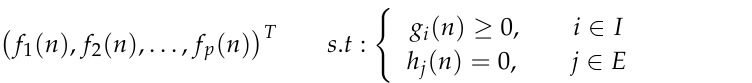
Figure 15. 3D Pareto front results of the partial load operating condition. Figure 16. 3D Pareto front results of the high load operating condition.